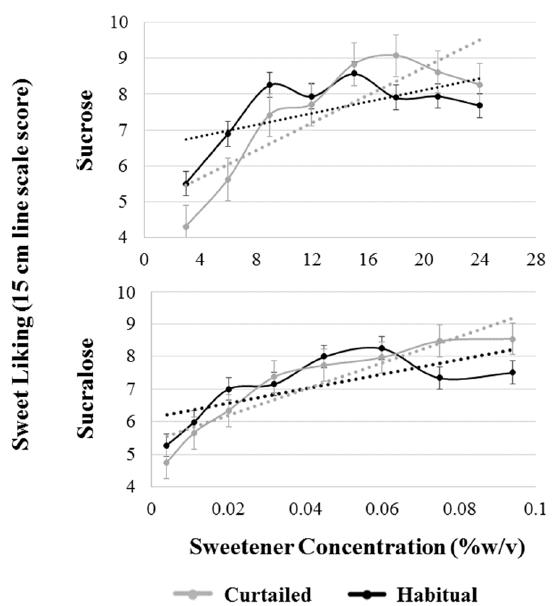
Figure 5. Comparison of patterns of sweet liking of sucrose and sucralose after a habitual and curtailed night of sleep for all participants. Black dotted lines represent the best fit linear slope for the pattern of liking after the habitual night; gray dotted lines represent the best fit linear slope for the pattern of liking after the curtailed night. The habitual liking slope and curtailed liking slope are significantly different for sucrose ( p = 0.001), but not sucralose ( p = 0.129). Error bars represent the standard error of the mean.